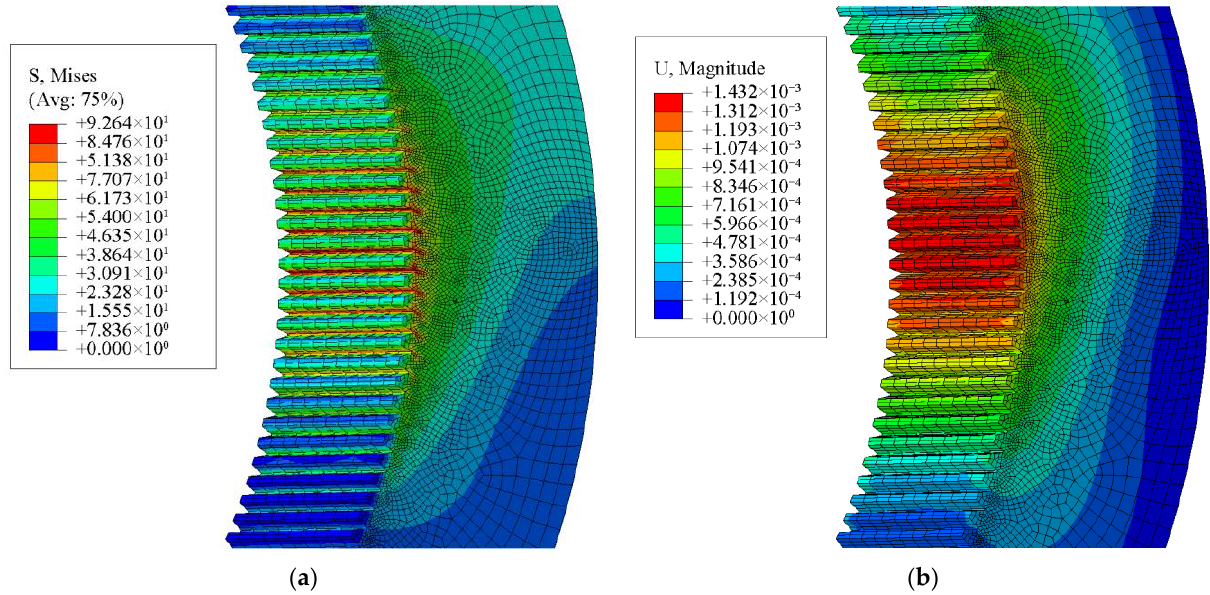
Figure 21. ( a ) Equivalent stress of the rigid wheel after loading; ( b ) equivalent deformation of the rigid wheel after loading.